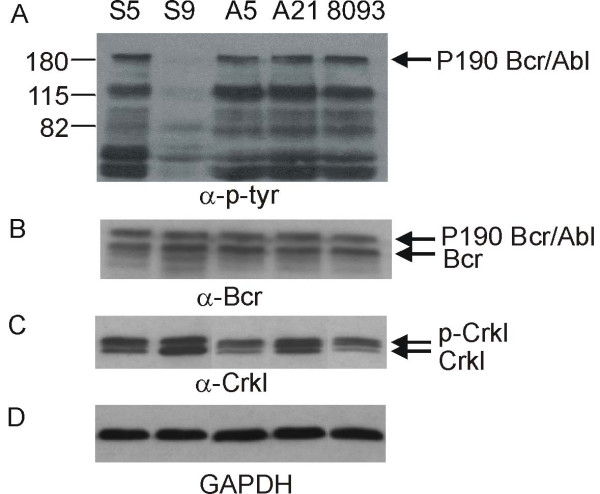
Western blot analysis of effect of nilotinib on the tyrosine kinase activity of Bcr/Abl in vivo. S-5 and S-9 are lymphoma lysates prepared from two mice transplanted with 8093 cells in the nilotinib-treated group 23 hours and 2 hours after the last nilotinib treatment respectively. Lanes A-5, A-21 and 8093 contain lysates prepared from lymphoma cell lines A-5, A-21 and 8093. 8093 is the parental cell line and A-5, A-21 lymphoma cells were isolated from two mice in the nilotinib treatment group and cultured ex vivo. All leukemia cell lysates shown here are from mice, which developed lymphoma during Nilotinib treatment. Membranes were reacted with antibodies indicated below each panel. Arrows indicate the positions of P190 Bcr/Abl, P160 Bcr (endogenous mouse) and phosphorylated and non-phosphorylated Crkl.